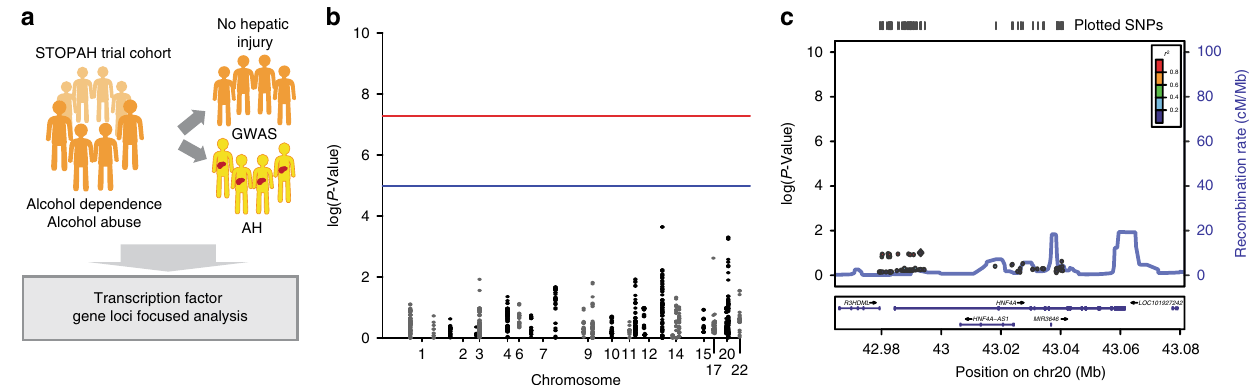
Fig. 8 GWAS study does not show an association of LETF SNPs with the development of AH. a Detection of single nucleotide polymorphisms (SNP) associated to AH in transcription factor gene loci. In this study we compared patients had alcohol dependence but with no evidence of liver injury ( n = 318) and patients with alcohol dependence and biopsy-proven severe AH ( n = 332). b Manhattan plot of all the SNP present in the selected genomic regions (see also Supplementary Data 3). c LocusZoom plot of